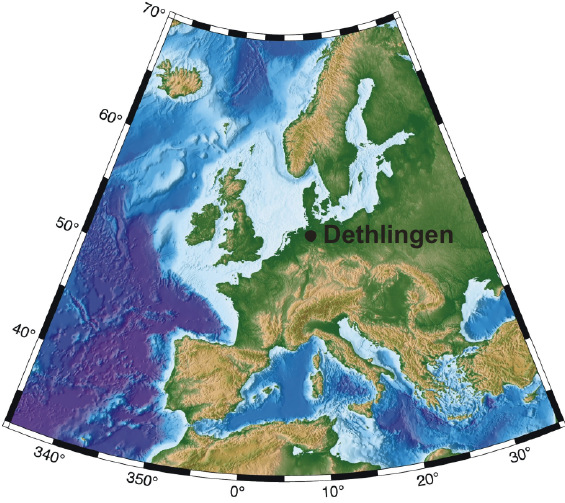
Fig. 1. Map indicating the location of the Dethlingen